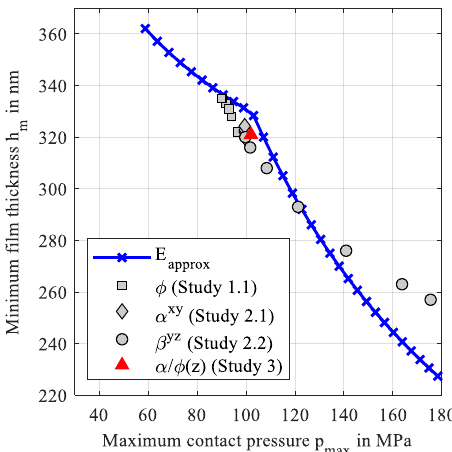
Figure 21. Estimated and calculated minimum film thicknesses over the maximum contact pres-